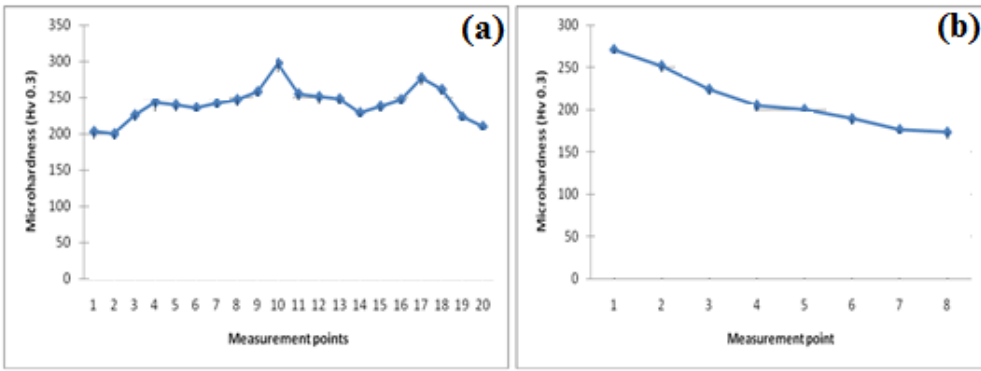
Figure 6. Microhardness test results of sample S1 ( a ) horizontal and ( b ) vertical.